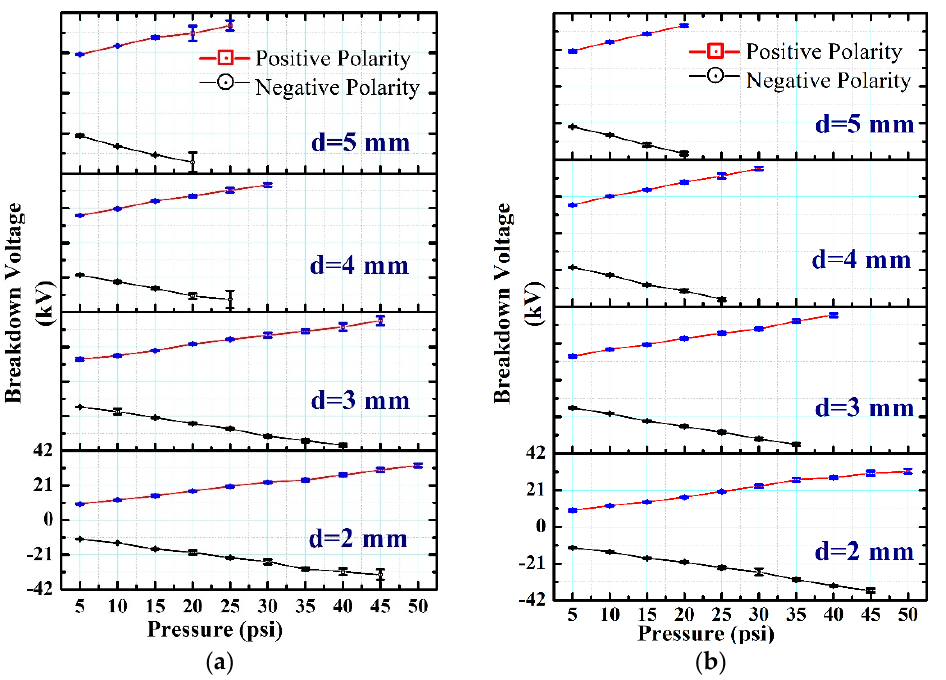
Figure 14. Results of Bruce and Rogowski profiles. ( a ) Bruce. ( b ) Rogowski.